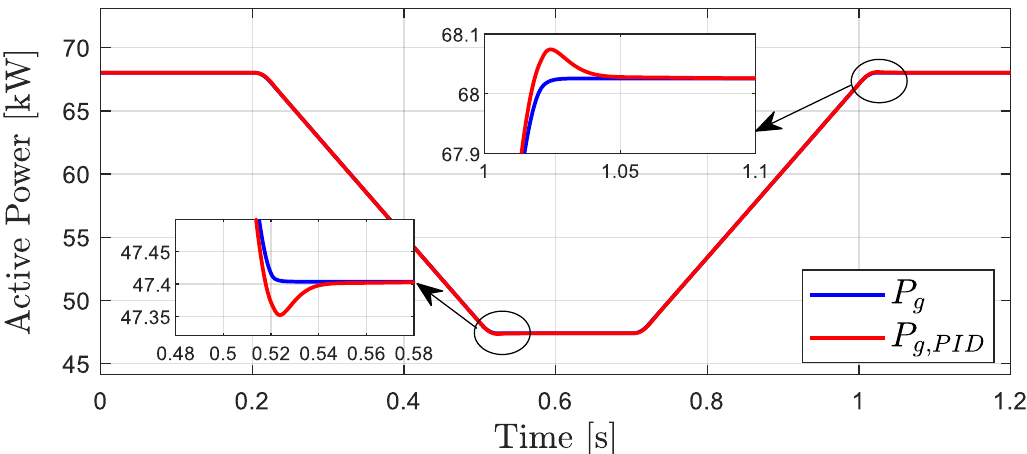
Figure 11. Active power to the grid time profile comparison.